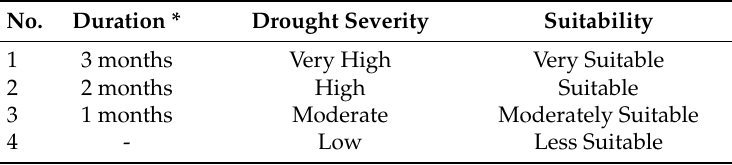
Table 4. Drought duration, severity, and location